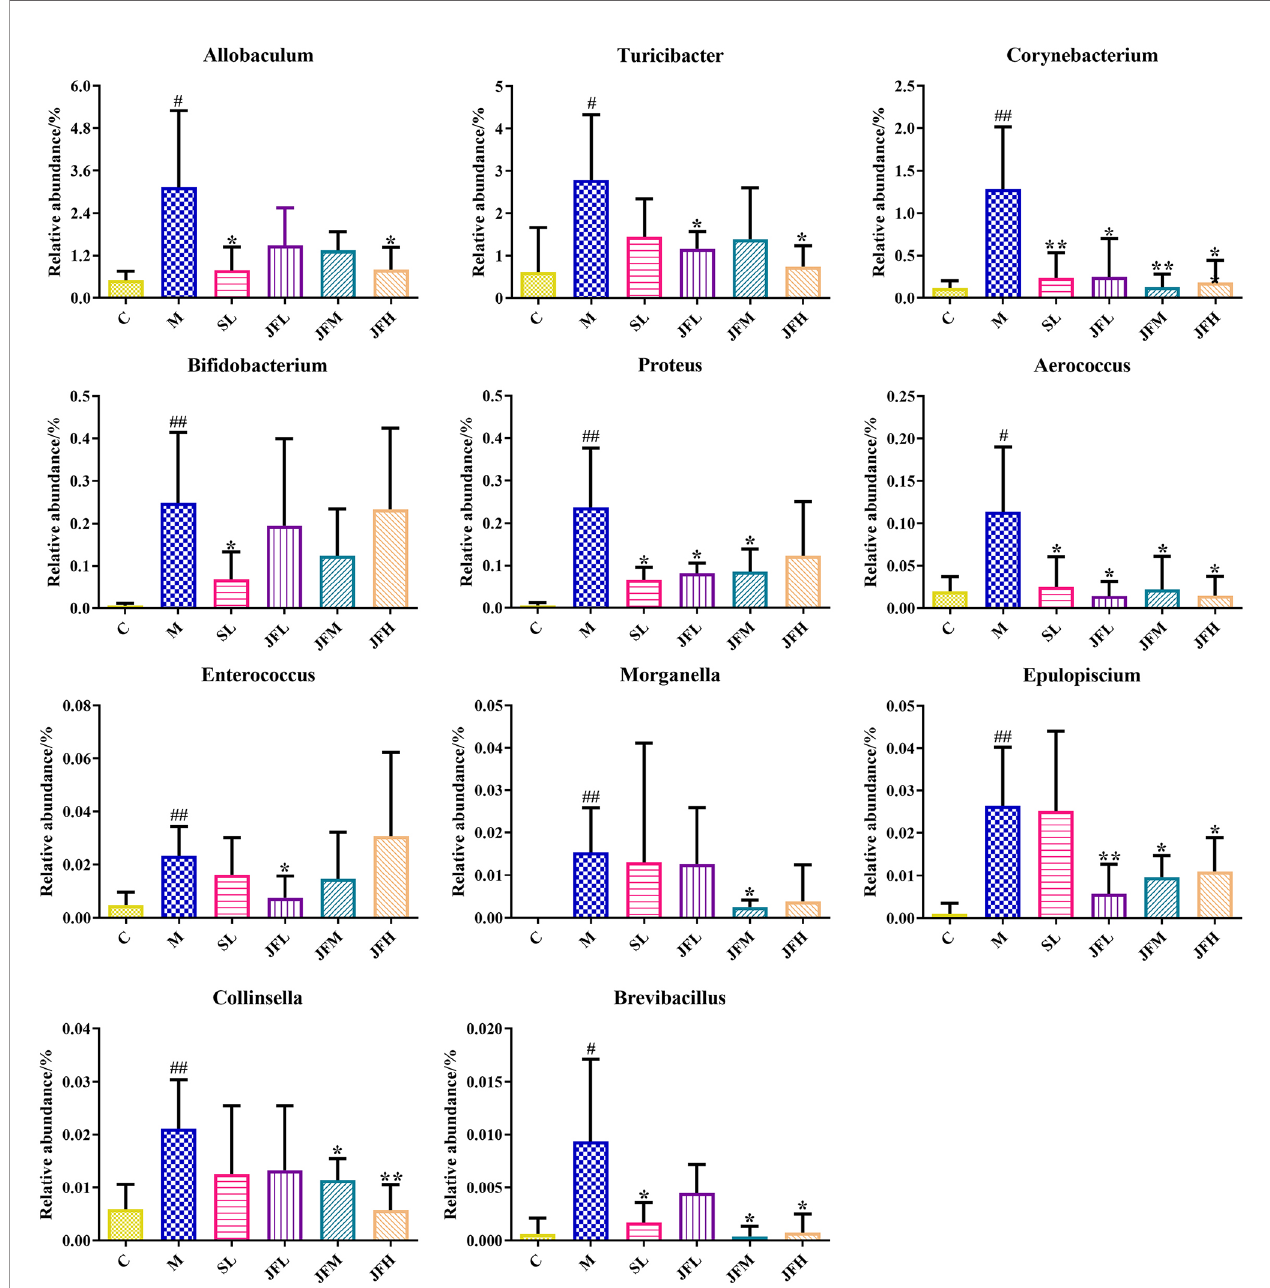
FIGURE 6 | Average relative abundance of difference features fl ora in feces of all groups. (C) control group; (M) model group; (SL) positive group; (JFL) low dose group of JF extract; (JFM) medium dose group of JF extract; (JFH) high dose group of JF extract. Data are presented as mean ± SD, n = 6. # P < 0.05, ## P < 0.01: model vs control; *P < 0.05, **P < 0.01: treatment vs